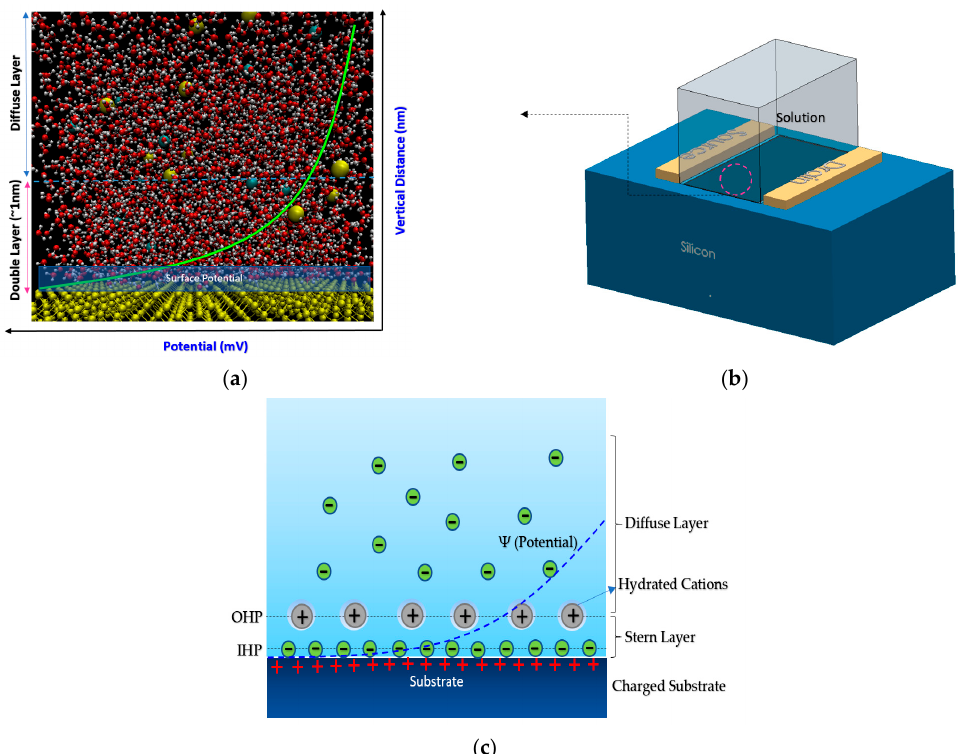
Figure 2. Showing how atomistic molecular dynamics simulation scales have been used to estimate the charge density on the surface of oxide layer (here SiO 2 ): ( a ) Showing the silicon in atomic representation, which clearly shows the atomistic distribution of water and ions in the vicinity of surface silicon, which create a surface potential decaying into stable value in near zero in diffusion layer. The double layer has been shown whereby its effect would create a specific potential on the surface based on the ionic strength in the solution. Molecular dynamics can be used to estimate this potential in very complex solution containing biomolecules; ( b ) showing 3D sketch of a FET device; ( c ) potential and ions layers on the interface of electrolyte and substrate in sensor.